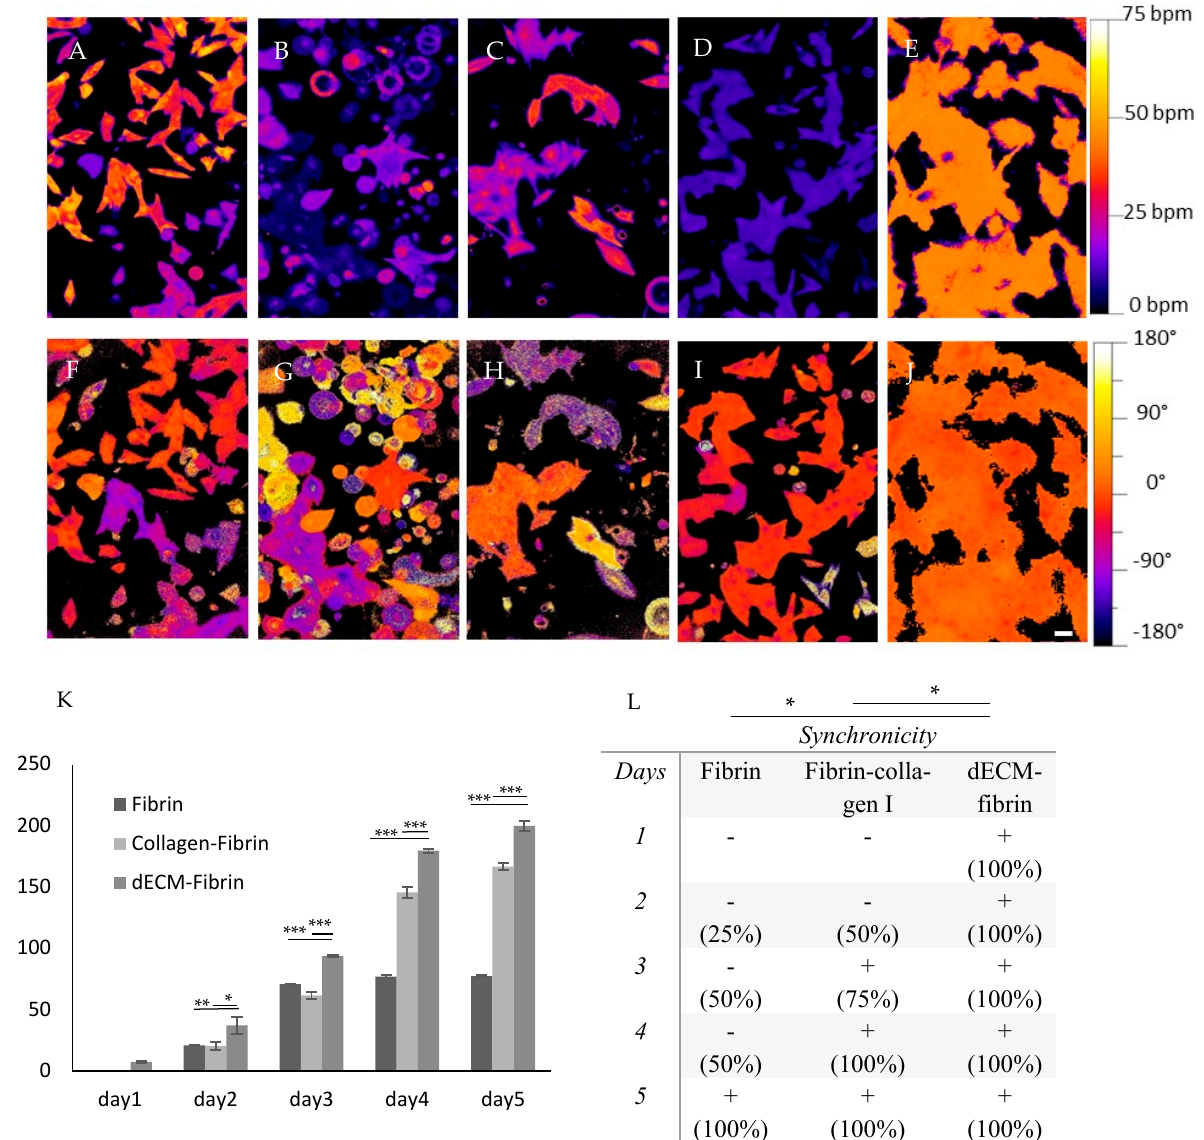
Figure 6. Calcium transients and beating characteristics of cardiomyocytes interacting with different hydrogels. ( A – J ) Calcium imaging for neonatal cardiomyocytes seeded onto different hydrogels (2D culture) and tissue culture plates (control). ( A – E ) Frequency ( A – E ) and Phase ( F–J ) are presented. Positive values indicate earlier beating, while negative values indicate retardation. Hydrogels used in calcium imaging: tissue culture control ( A , F ), Matrigel ( B , G ), collagen I ( C , H ), fibrin-collagen I ( D , I ) and dECM-fibrin ( E , J ). ( K ) The beating rate for the first 5 days for neonatal cardiomyocytes seeded 3D in fibrin, fibrin-collagen I and dECM-fibrin hydrogels is shown. ( L ) Synchronization as the percentage of synchronously beating wells (four wells per condition) over a period of 5 days in the 3D hydrogels is presented. Ns = p > 0.05, * = p ≤ 0.05, ** = p ≤ 0.01, *** = p ≤ 0.001. Scale bar: 100µm.